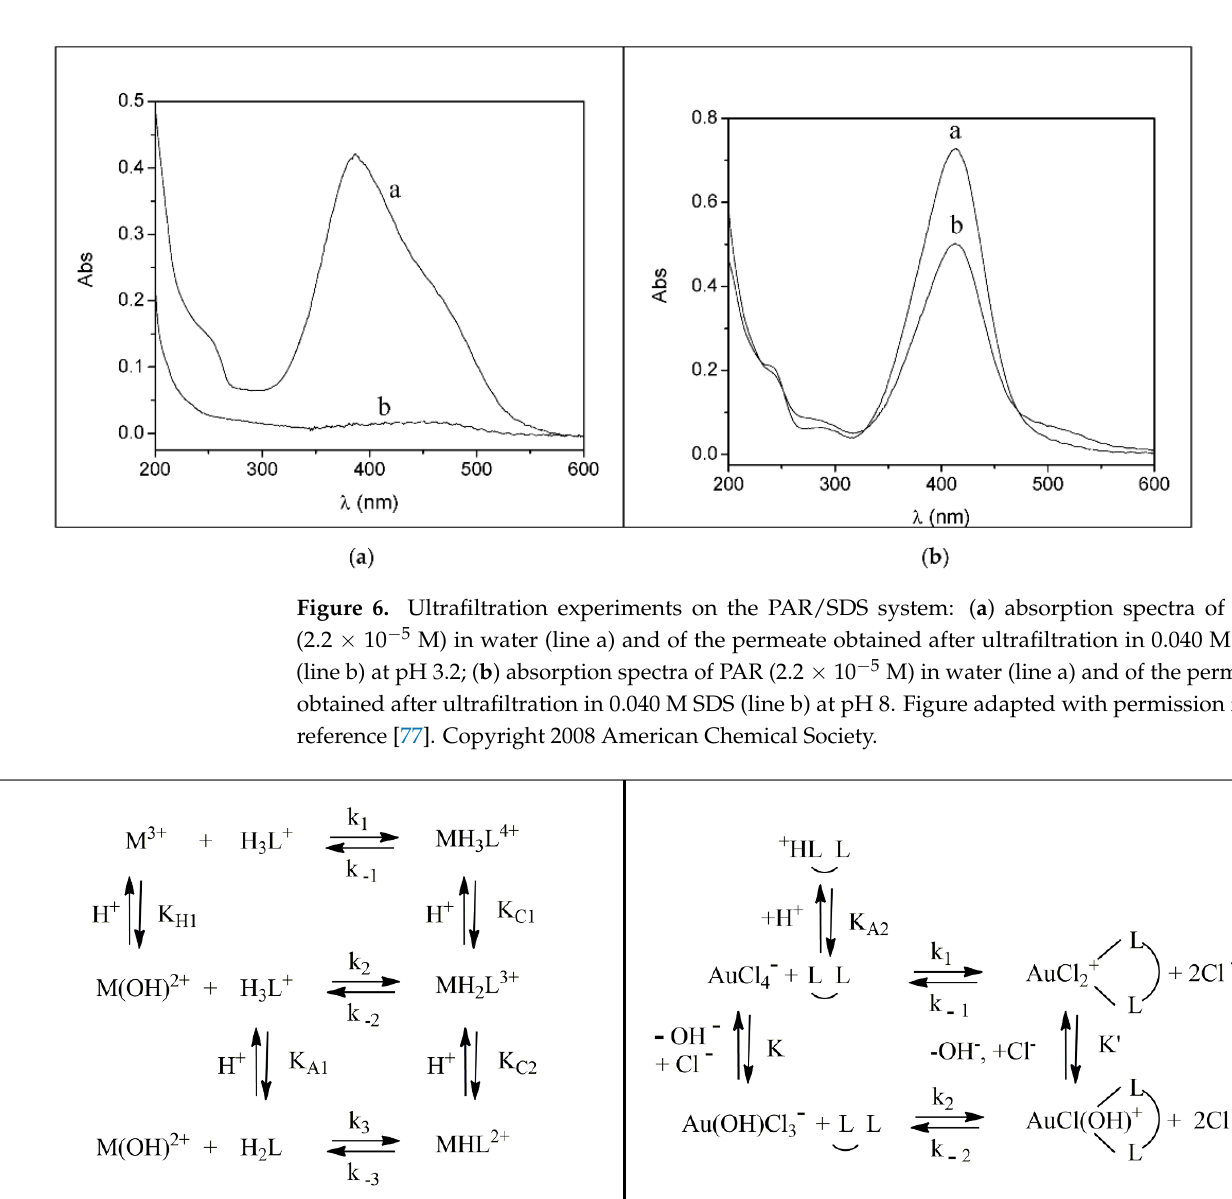
Figure 6. Ultrafiltration experiments on the PAR/SDS system: ( a ) absorption spectra of PAR (2.2 × 10 −5 M) in water (pH 3.2) and ( b ) of the permeate resulting after ultrafiltration in 0.040 M SDS (pH 8). Figure adapted with permission from reference [77]. Copyright 2008 American Chemical Society.